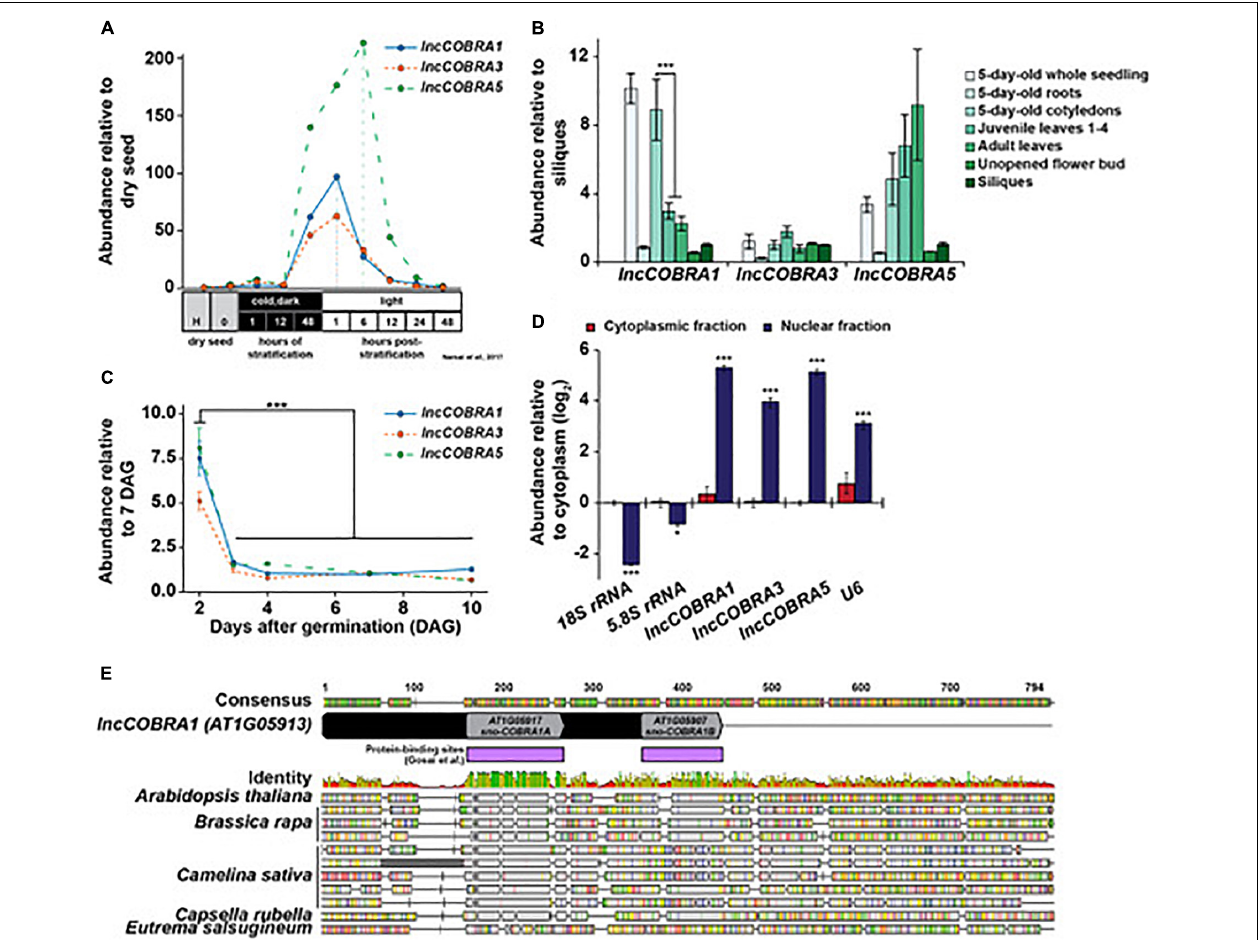
FIGURE 1 | Identification and expression of highly conserved, protein-bound lincRNA, lncCOBRA1. (A) Abundance of lncCOBRA1 , lncCOBRA3 , and lncCOBRA5 during germination as previously measured by RNA-seq (Narsai et al., 2017). Abundance is relative to dry seed after harvest. Raw values are listed in Supplementary Data Set 3 . (B) Abundance of lncCOBRA1 , lncCOBRA3 , and lncCOBRA5 in various tissues as measured by qPCR. Abundance is normalized by the geomean of UBC9 and UBC10 and is relative to siliques seedlings. *** Denotes p -value < 0.001, Wilcoxon t -test. (C) Abundance of COBRA1 , lncCOBRA3 , and lncCOBRA5 during early seedling development as measured by qPCR. Abundance is normalized by the geomean of UBC9 and UBC10 and relative to 7-day-old seedlings. *** Denotes p -value < 0.001, Wilcoxon t -test. (D) Abundance of lncCOBRA1 , lncCOBRA3 , and lncCOBRA5 in nuclear and cytoplasmic fractions as measured by qPCR. Abundance is normalized to UBC9 and relative to cytoplasmic fraction. 18S rRNA and 5.8S rRNA are cytoplasmic positive controls and U6 is a nuclear positive control. *, *** Denotes p -value < 0.05, < 0.001, Wilcoxon t -test. (E) Conservation lncCOBRA1 in Brassica rapa, Camelina sativa, Capsella rubella, and Eutrema salsugineum. Conservation was examined using Geneious Prime (Geneious | Bioinformatics Solutions for the Analysis of Molecular Sequence Data, 2019). Protein-binding sites were identified in the nuclei from 10-day-old seedlings in (Gosai et al., 2015). Colors in identity: Green = 100%, green-brown = 30–100%, red < 30%